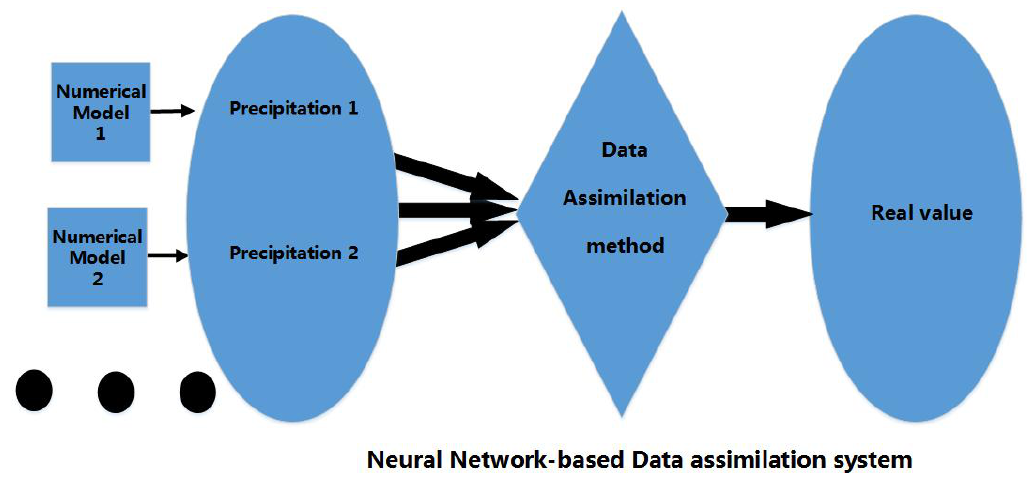
Figure 5. Posterior Data assimilation system.